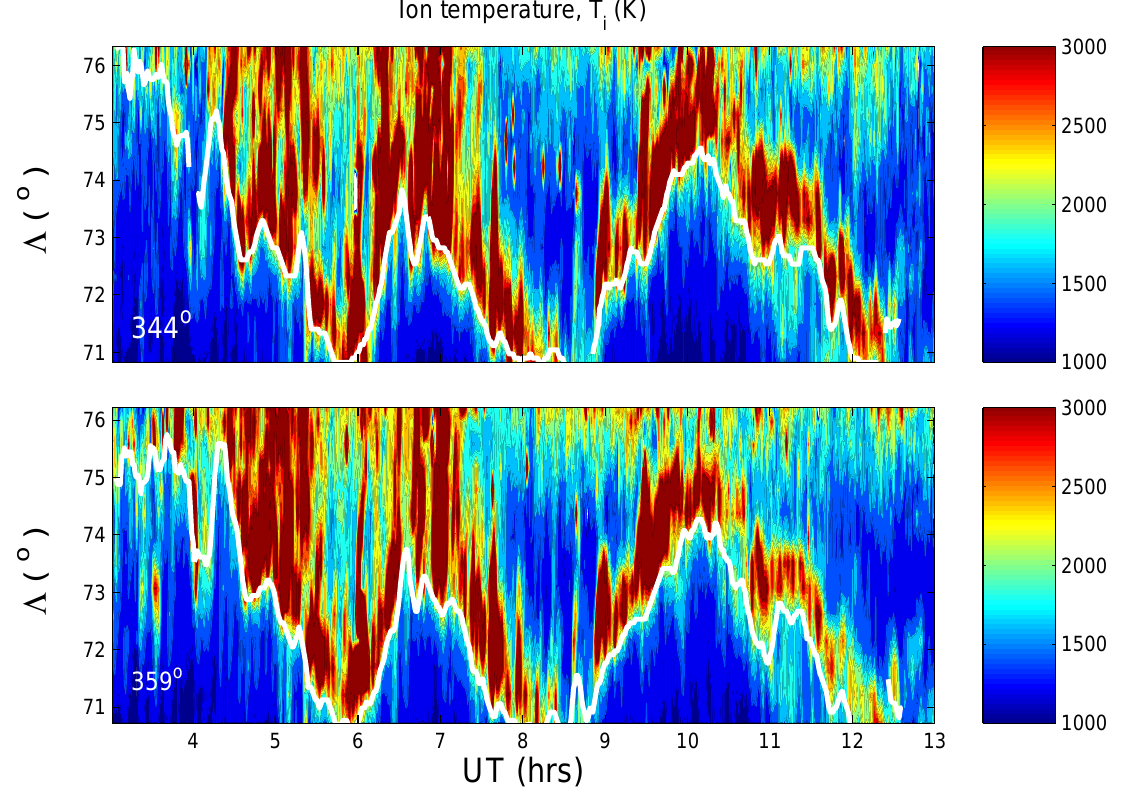
Fig. 2. One-min resolution observations on 23 November 1999 by the EISCAT VHF radar operating in the CP-4-B spilt-beam mode. Ion temperature, T i , is colour contoured as a function of UT and invariant latitude, 3 , for (top) beam 1 (344 ◦ east of geographic north and perpendicular to the L-shells) and (bottom) for beam 2 (359 ◦ east of geographic north). The white lines in each case show 5-point running means of the invariant latitude where T i =2000K on the equatorward edge of the high T i band.